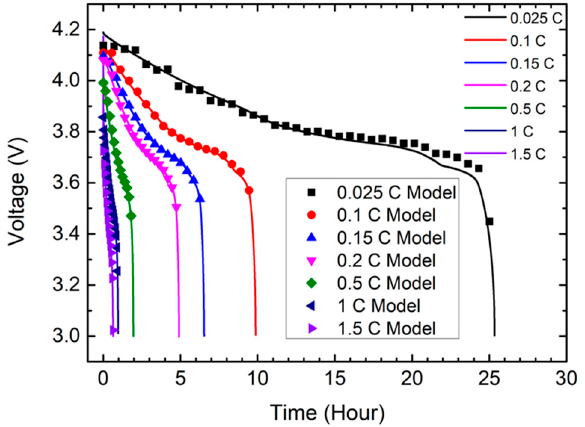
Figure 9. Curve of P brand 18650, Epoch = 100, look_back = 10.